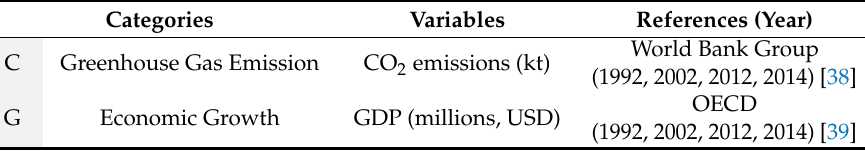
Table 1. The Variable Framework of the Fuzzy-set Ideal Type Analysis.